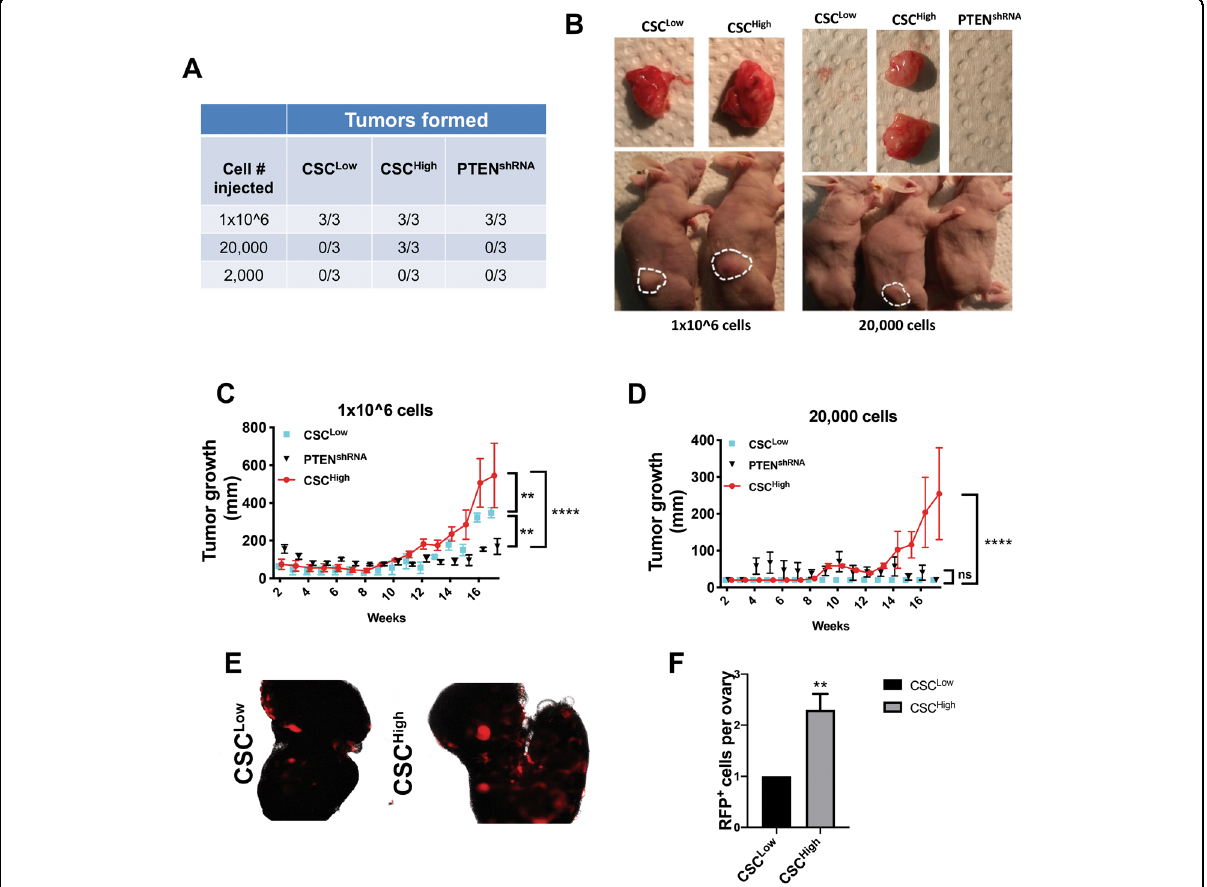
Fig. 4 CSC High demonstrates increased tumorigenic capabilities in vivo and increased adhesion to the ovary. A Table showing the number of mice forming tumors in the different concentrations ’ groups injected with PTEN shRNA , CSC High , or CSC Low . B Images comparing tumors from CSC Low and CSC High at 1 × 10 6 of cells and 20,000 cells injected. C , D Tumor growth over time was measured by calipers for 1 × 10 6 cells and 20,000 cells injected. Statistical analysis was performed using two-way ANOVA. ** p < 0.01; **** p < 0.0001, ns nonsigni fi cant. E , F Wounded ovaries incubated with PTEN shRNA -RFP cells for 24 h. Cells that attached to the ovary were counted using a NIKON Eclipse TS100. Three replicates in three independent experiments were quanti fi ed using Celigo (Nexcelom). Statistical analysis was performed using unpaired t -test. ** p <